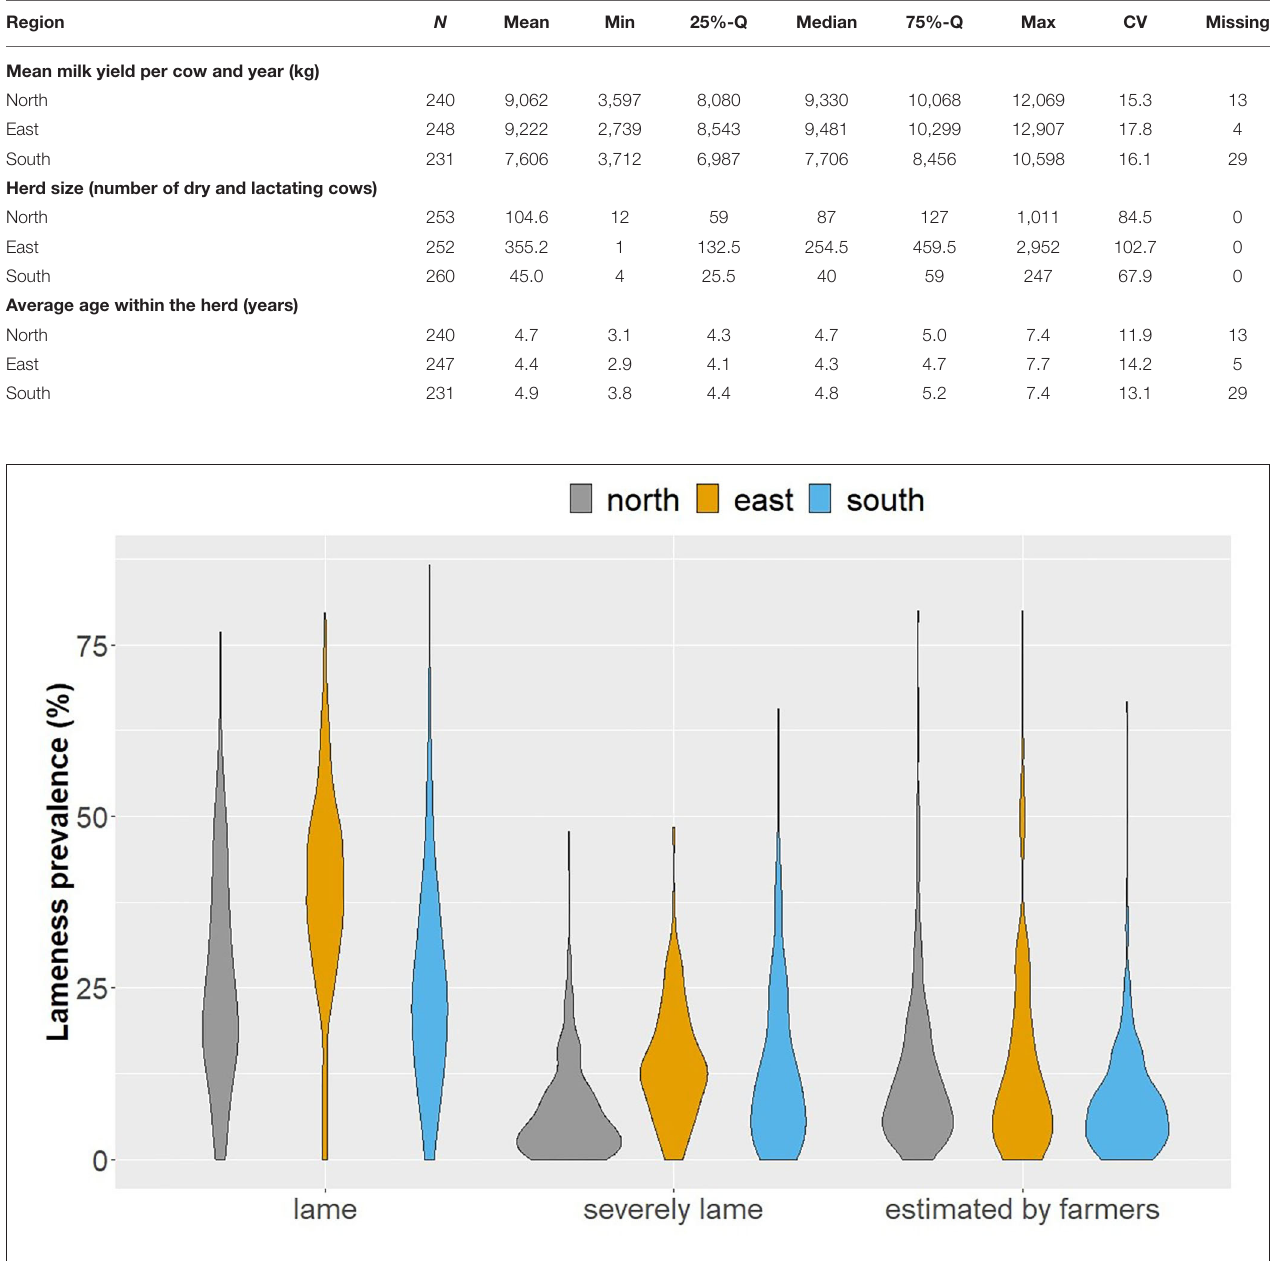
However, in the east and south, farmers who were neutral or agreed with the statement, “I am satisfied with the health of my herd,” had the highest FDI ( Table 6 ). Farmers who stated claw health to be a major breeding goal had higher FDI (east and south; Table 6